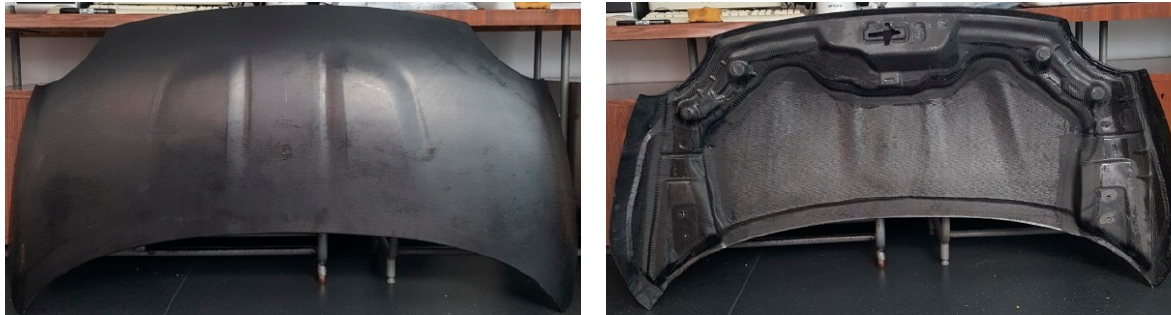
Figure 9. The obtained CFRP front hood “B” made by sandwich